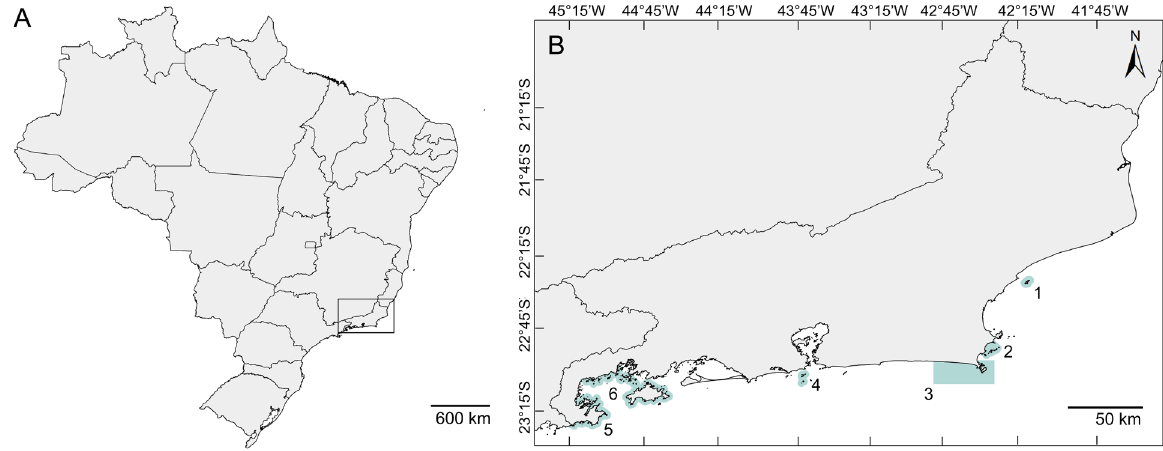
Figure 1. a) Brazil; b) Location of the analyzed MPAs in Rio de Janeiro State. 1-Santana MPA; 2-Pau-Brasil MPA; 3-Arraial do Cabo MPA; 4-Cagarras MPA; 5-Cairuçu MPA; 6-Tamoios MPA (donor